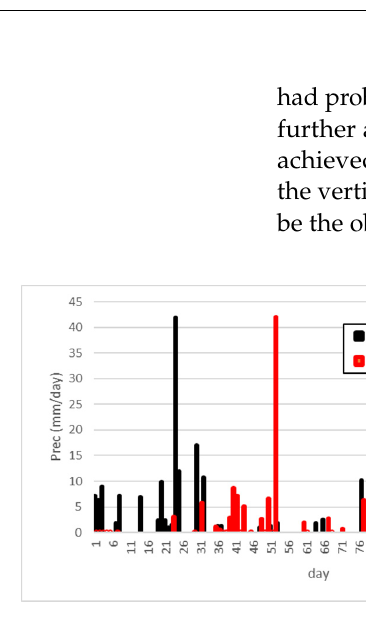
Figure 7. Histogram of daily precipitation values (mm) at Napoli Capodichino ( a ) and Montemarano ( b ) over the considered period: observational and model data for the nearest grid point.